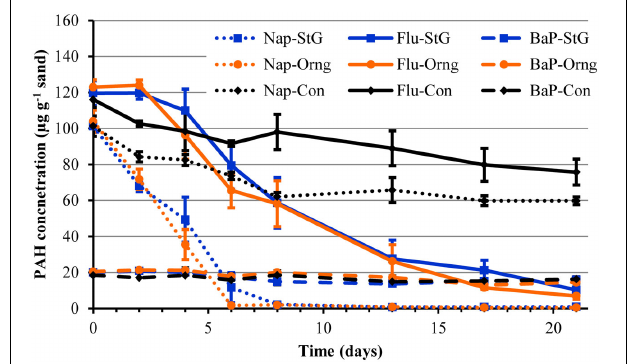
FIGURE 3 | Measured PAH concentrations in mesocosm columns containing sand from the oil impacted beach, Orange, and the non-impacted beach, St. George, over time. The sand was spiked with a mixture of 100 μ g g − 1 naphthalene, 120 μ g g − 1 fluorene, and 20 μ g g − 1 benzo[ α ]pyrene prior to column setup. Lines in blue represent St. George (StG) sand mesocosm samples, lines in orange represent Orange (Orng) beach, and black lines represent control abiotic columns (Con). Solid lines represent fluorene (Flu) concentrations, dotted lines represent naphthalene (Nap) concentrations, and the dash line represents benzo[ α ]pyrene